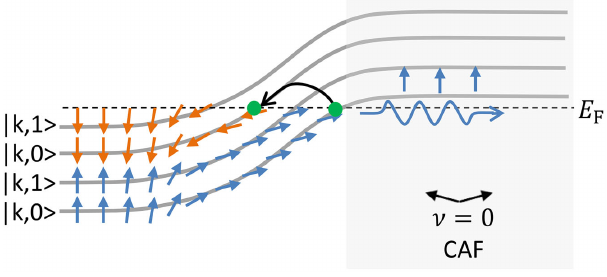
FIG. 9. A schematic of the gradual canting of spins due to the effective field created by the CAF state following Ref. [14]. The canting enables a gapless transition of an electron from the inner edges (quasi spin up) to the outer edges (quasi spin down), with the net spin angular momentum carried away by the emission of a SW into the CAF phase. Transition in the opposite direction reverses the net spin angular momentum transmitted and, hence, the sign of the detected nonlocal